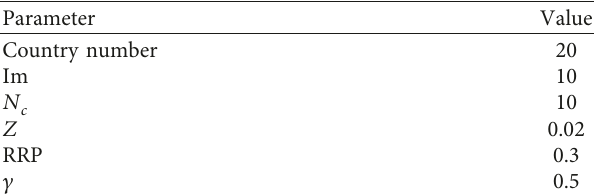
equals Table 5: Optimal parameters of the MIC algorithm. oe